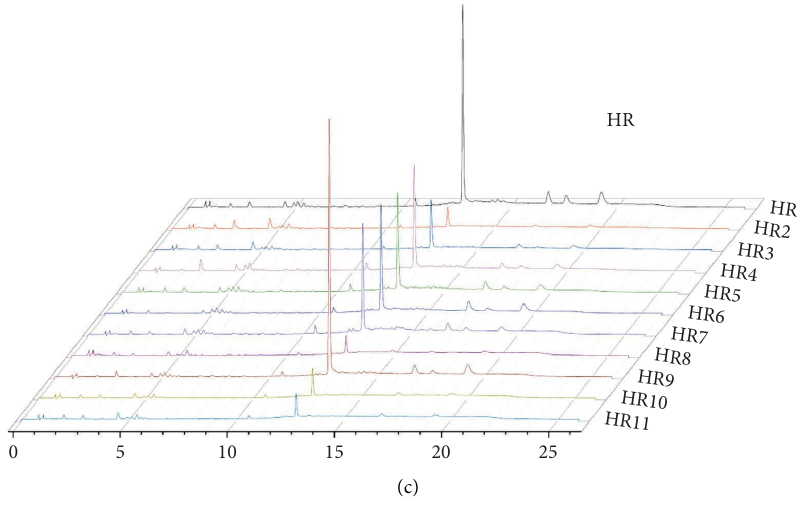
Figure 3: HPLC fngerprints of 11 batches of C. tubulosa